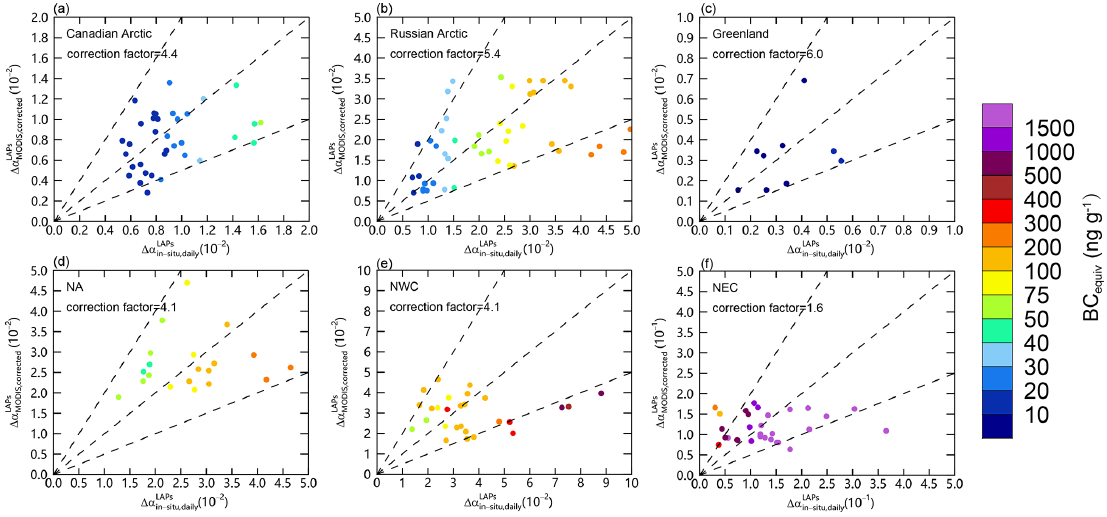
Figure 5. Scatterplots of (cid:49)α LAPs versus (cid:49)α LAPs . Panels (a) – (f) represent the snow samples collected in the Canadian Arctic, MODIS,corrected in situ,daily Russian Arctic, Greenland, North America, northwestern China, and northeastern China, respectively.